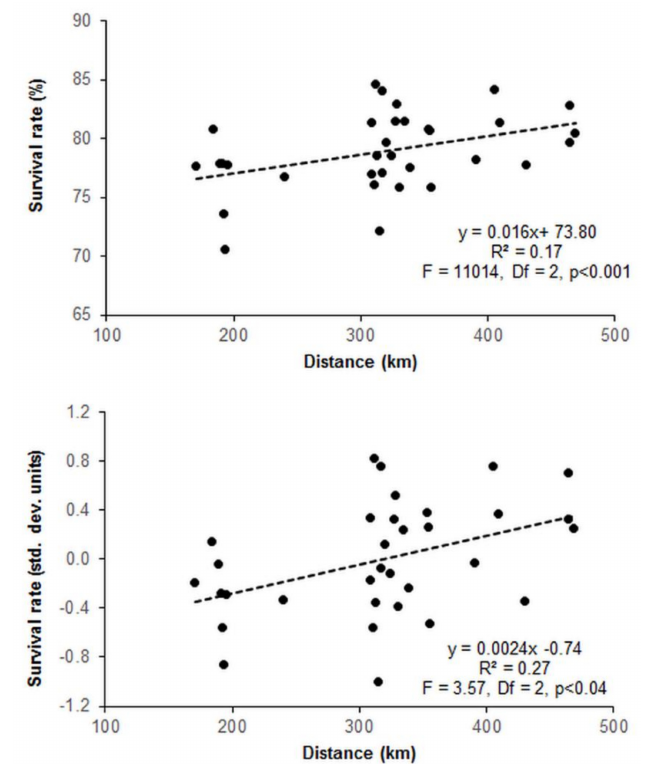
Figure 6. Relationships between the survival rate of the tested provenances after 15 years and the geographic distance between their origin sites and the meeting zone of the refugial lineages. Survival rate is expressed both in nominal and standardized units for each test site. The dots show the mean survival rate of 33 tested provenances from the western lineage on eight test